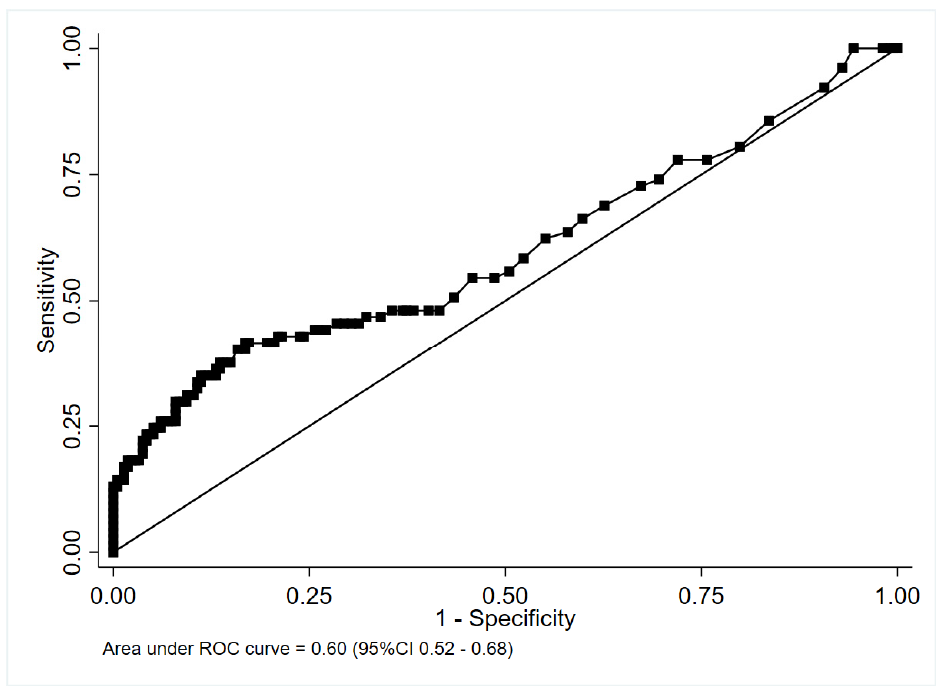
Figure 2. Receiver-operating characteristic curve of serum procalcitonin for the diagnosis of microbiologically proven bacterial pneumonia.